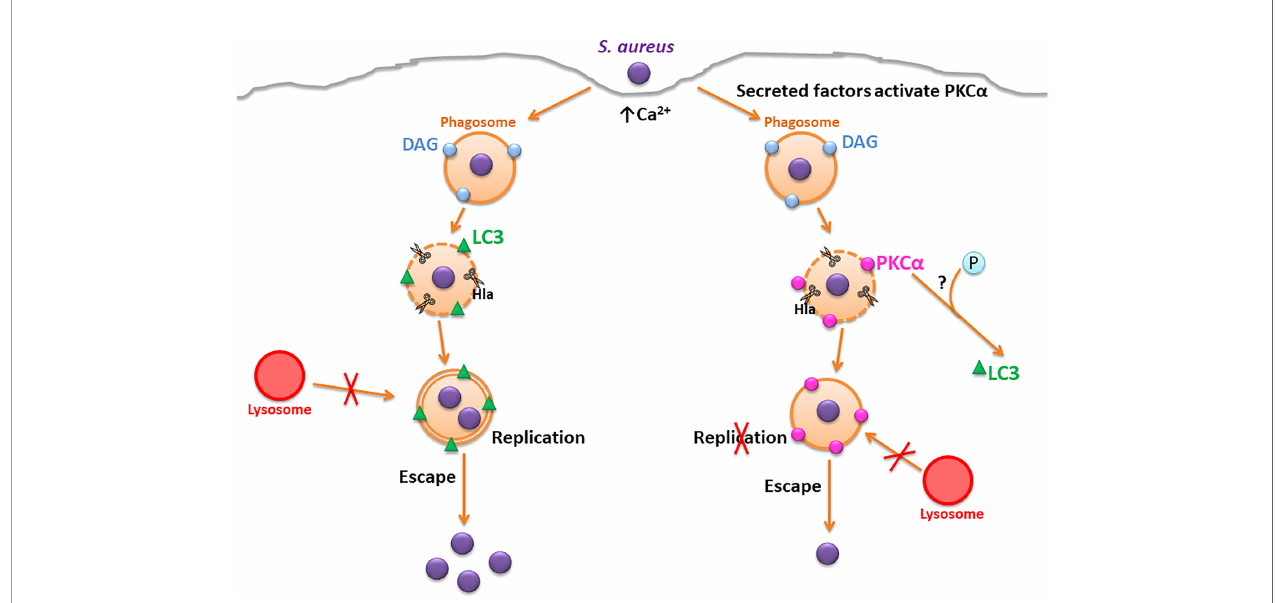
FIGURE 8 | Proposed model. On the left, the canonical S. aureus intracellular traf fi c is depicted, where Hla causes the disruption of the phagosomal membrane and the activation of autophagic response. S. aureus replicates in the interior of autophagosomes where it resides and fi nally, escapes to the cytoplasm. On the right, the overexpression of PKC a causes a disruption in the regular S. aureus traf fi c. Hla causes the recruitment of PKC a to the phagosomal membranes, which inhibits autophagy and impairs S. aureus intracellular